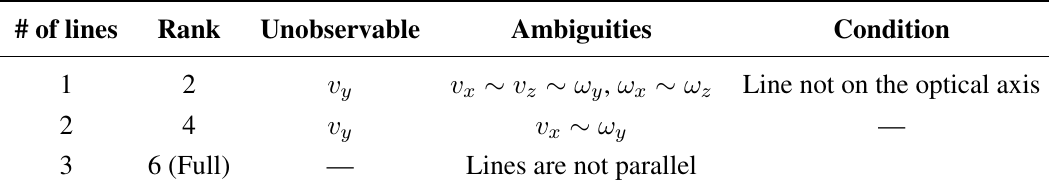
Table 1. Unobservable and ambiguous velocity